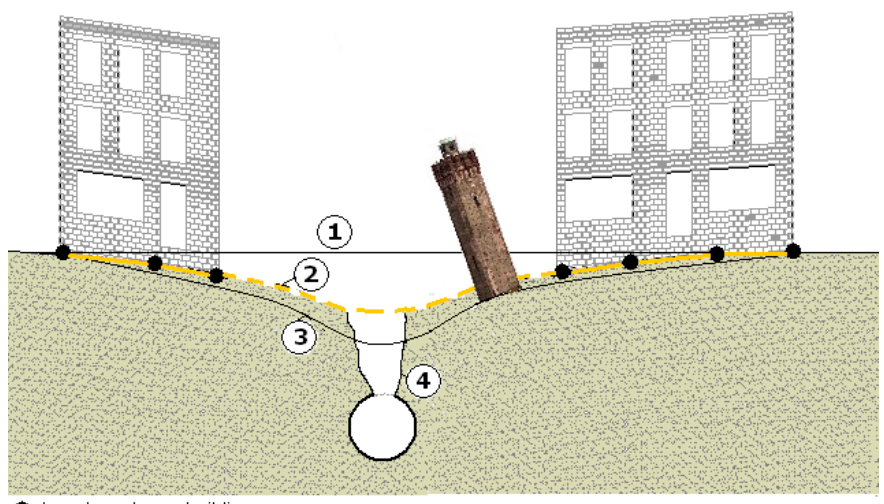
Figure 9. A conceptual model to explain ground loss: ( 1 ) original ground surface; ( 2 ) ground surface derived from subsidence of benchmarks (marked by solid circles) mainly on buildings. Dashed line indicates trough designed by interpolation (due to limitation in recording data); ( 3 ) predicted ground surface at greenfield, following the Gaussian curve introduced by Peck [1]; ( 4 ) formation of sinkhole (daylight failure).